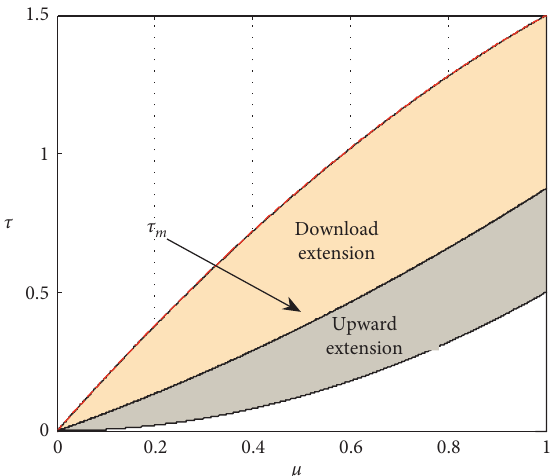
Figure 5: The strategic choices of the high-quality